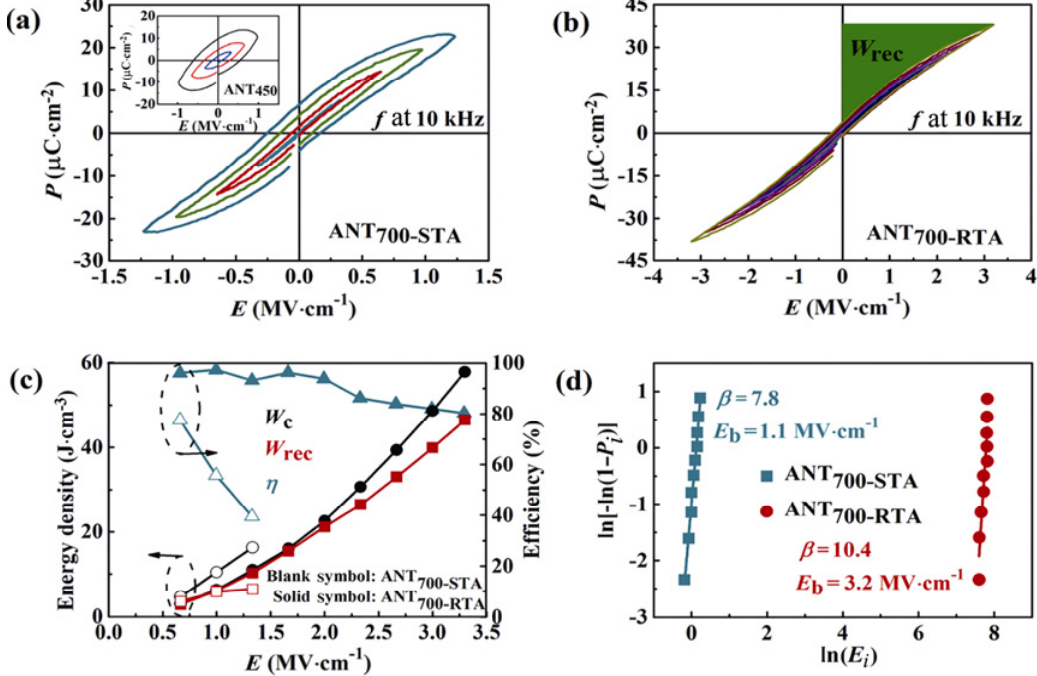
Fig. 4 RT P–E loops for (a) ANT 700-STA and (b) ANT 700-RTA films (the inset in (a) shows the representative P–E loops of ANT 450 film). (c) W c , W rec , and ŋ of ANT 700-STA and ANT 700-RTA films as functions of applied electric field where W c is the charged energy density and η = W rec / W c . (d) Weibull plots of dielectric breakdown field ( E b ) for ANT 700-STA and ANT 700-RTA